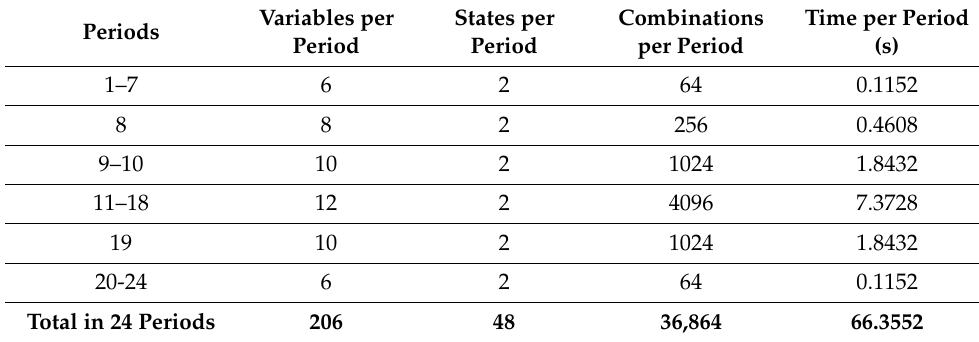
Table 2. Combinations, states, and expected simulation time with two states.